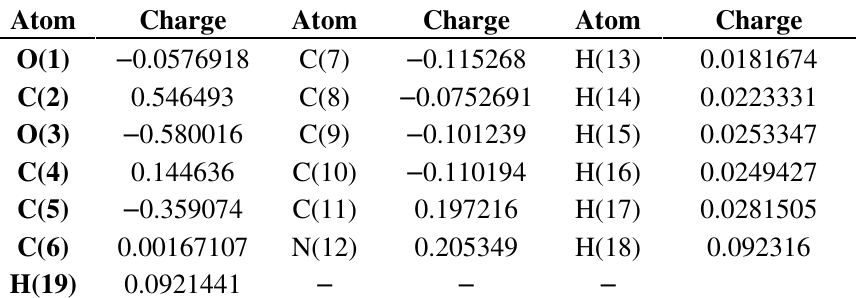
Table 1. The atomic charges of